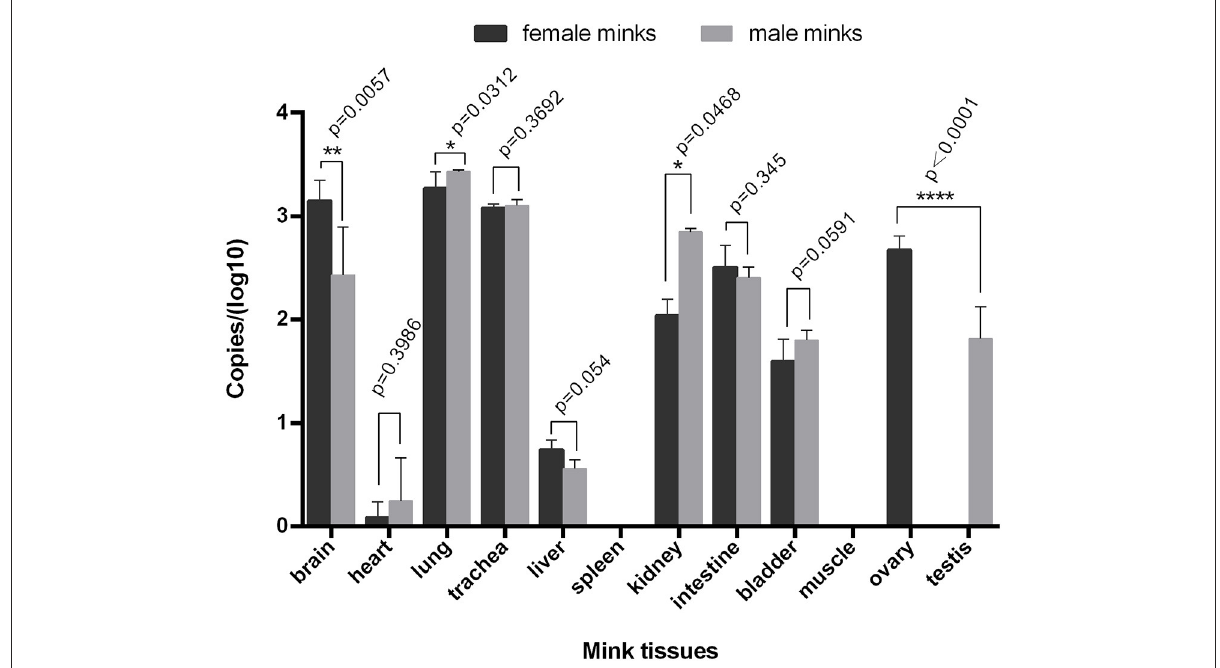
FIGURE4 Distribution of IFN- ε in mink. The MiIFN- f gene was highly expressed in brain, lung, tracheal, kidney, intestinal, bladder, ovarian, and testis tissues; The expression of MiIFN-e displayed significant differences in female and male mink’s brain ( p < 0.01), lung ( p < 0.05), reproductive organ tissue ( p < 0.0001). *, p < 0.05; **, p < 0.01; ***, p < 0.001.